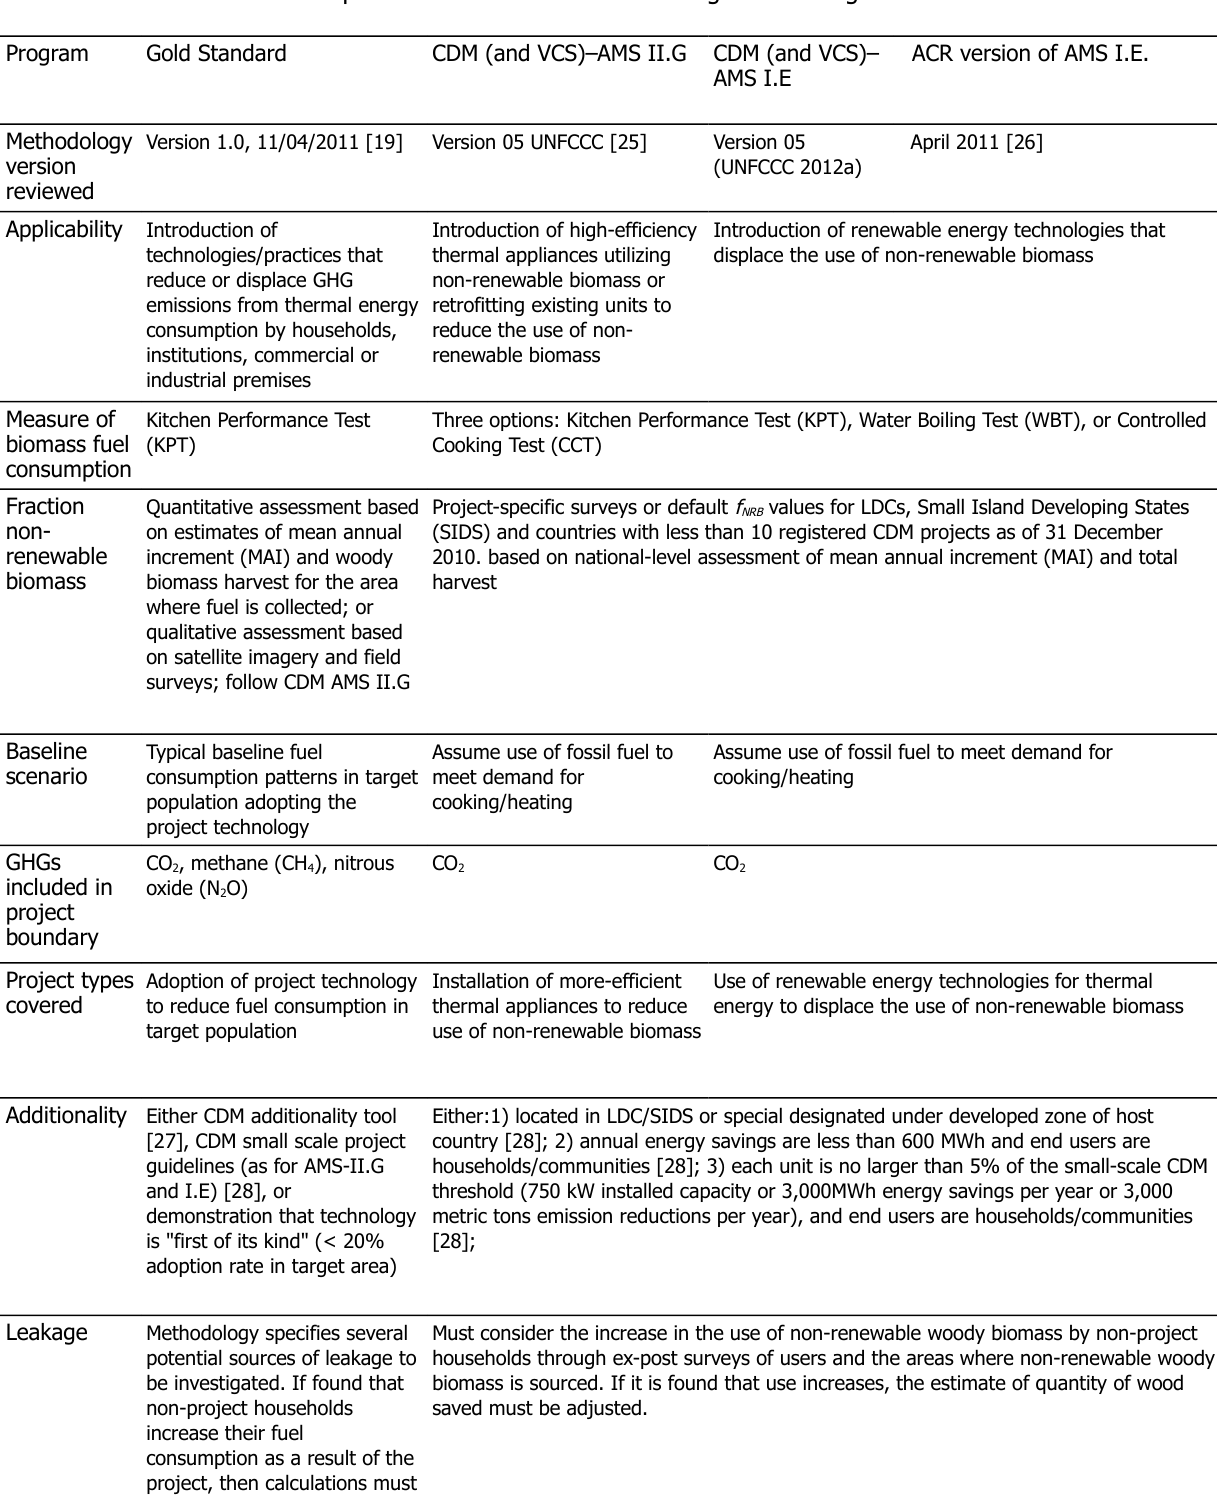
Table 1. Improved cookstove carbon crediting methodologies